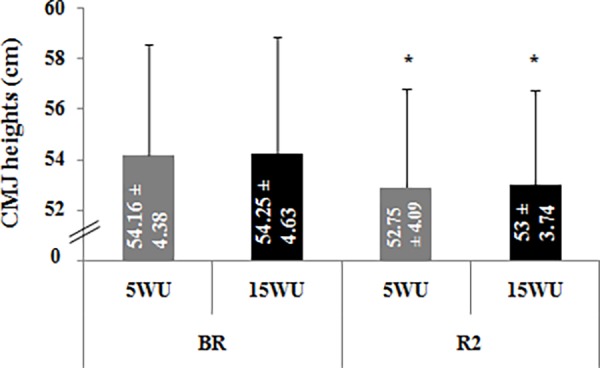
Counter movement jump heights (cm) (mean ± SD, n = 12) measured after the 5-minute (5WU) and the 15-minute (15WU) warm-up, before (BR) and during (R2) Ramadan.*: significant difference in comparison with BR.